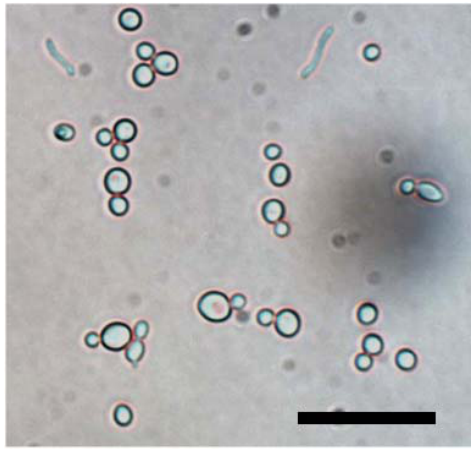
concentration. The scale bar is 25 µm.